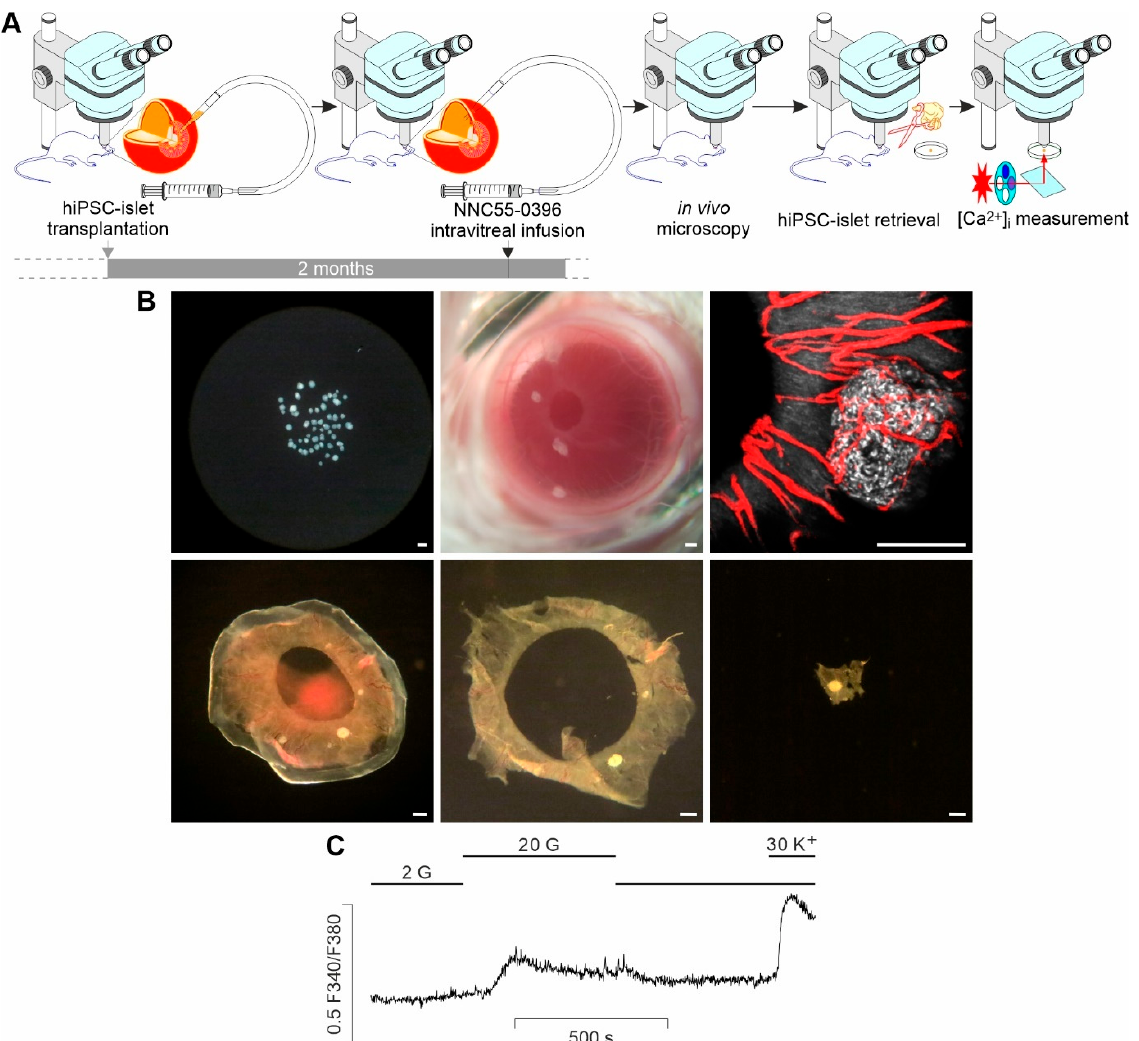
Figure 1. Transplantation of single, non-aggregated hiPSC-islets onto the immunodeficient mouse iris, intravitreal infusion of NNC55-0396, in vivo microscopy, intact retrieval of single intraocular grafts and ex vivo [Ca 2+ ] i measurements in retrieved single intraocular grafts. ( A ) Experimental design schematic. ( B ) Stereomicroscopic graphs and confocal microscopic images showing hiPSC-islets of suitable size (<250 µm in diameter) selected for ACE transplantation ( upper left ); single, non- aggregated hiPSC-islets engrafted onto the iris ( upper middle ); light backscatter (grey) merged with fluorescence of Qtracker 565 (red) injected into the lateral tail vein ( upper right ) from an intraocular hiPSC-islet graft; single, non-aggregated hiPSC-islet grafts sandwiched between the iris and cornea excised as a whole from the eyeball ( lower left ); single, non-aggregated hiPSC-islet grafts engrafted on the iris peeled from iris–cornea sandwich ( lower middle ) and an intact hiPSC-islet graft attached to a small piece of the iris ( lower right ). Scale bar = 200 µm. ( C ) A typical [Ca 2+ ] i trace illustrating glucose- and K + -induced [Ca 2+ ] i responses registered from a single hiPSC-islet graft retrieved at 2 months post-transplantation following intravitreal infusion of NNC55-0396.